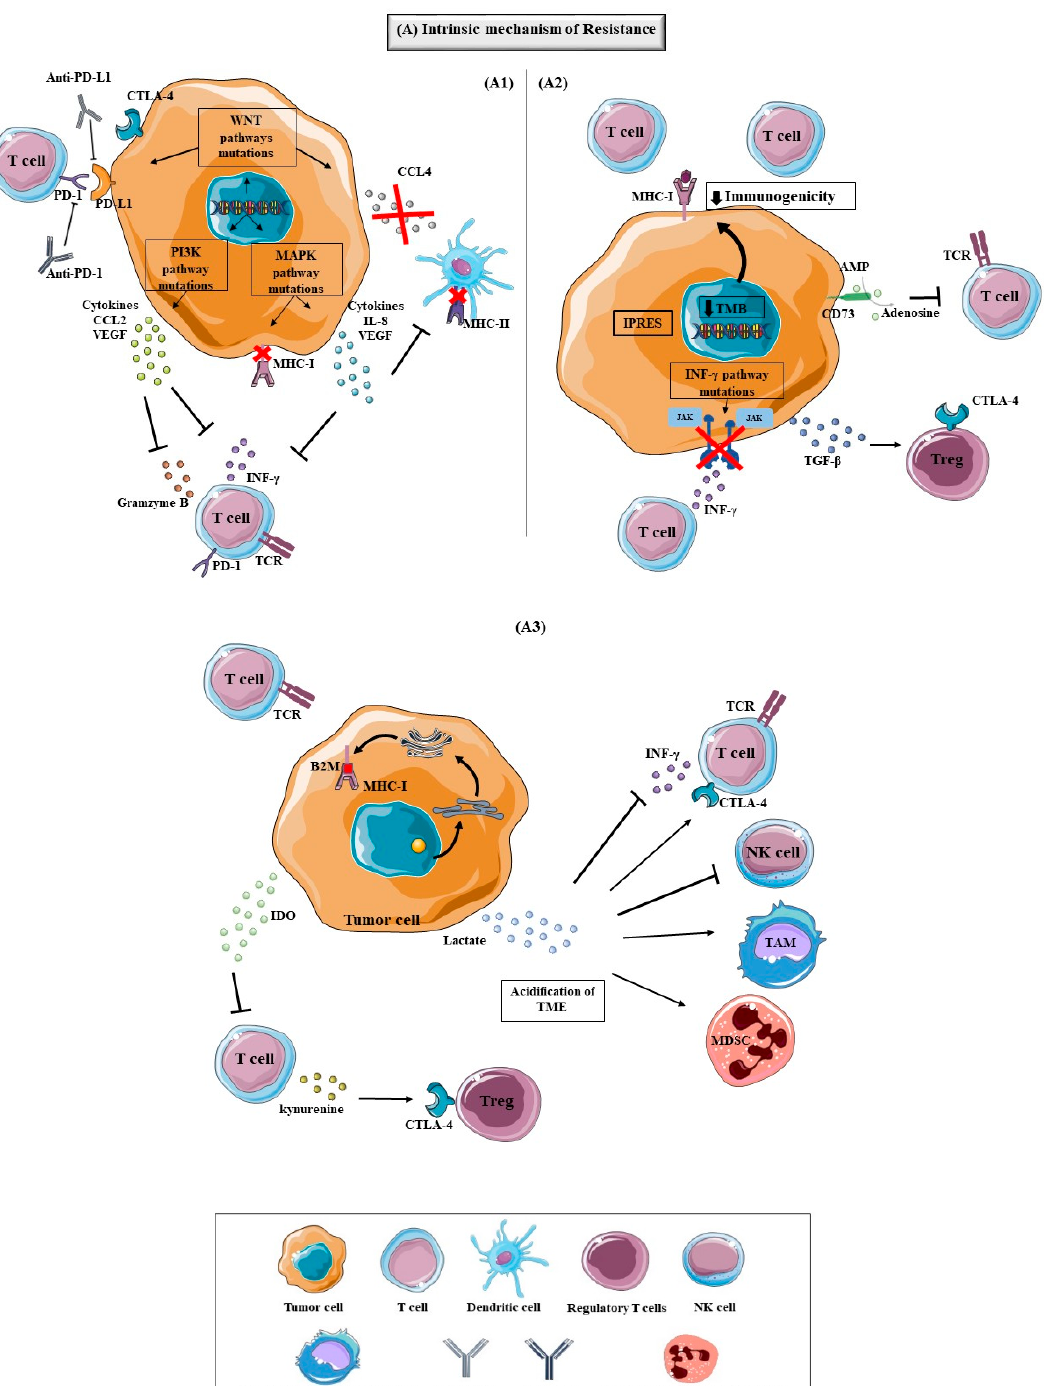
Figure 3. Intrinsic mechanisms of tumor resistance to immunotherapy: ( A1 ) The tumor cells have the ability to not respond to immunotherapy by the development of different mechanisms that have been described in different studies. One of the mechanisms that can lead to the resistance are the alterations of some signaling pathways in tumor cells that can cause the reduction or loss of antigens expression, preventing immune cell infiltration or function. The WNT signaling is one of these pathways that can be aberrantly activated in a variety of tumors and act in the tumor cell genesis, proliferation, invasiveness, metastatic and immune microenvironment regulation. In some studies, it was demonstrated that the WNT signaling can control the expression of PD-L1 and CTLA-4 and can reduce the expression of chemokine that attracts CD103+ DC (CCL4), decreasing the DC migration into the TME and contributing to the inhibition of activation and cytotoxic effects of T cells; The PI3K pathway is one of the responsible pathways that contributes to the development and growth of tumors and alterations in their intermediaries, like tumor suppressor protein phosphatase and tensin homolog